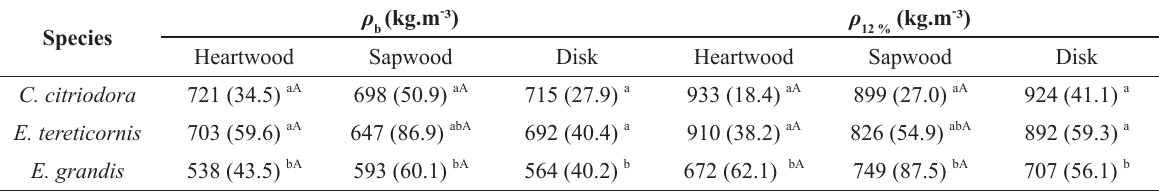
Weighted basic ( ρ ) and apparent ( ρ ) mean densities (followed by standard deviation) of heartwood and sapwood b 12% regions and of the entire disk.